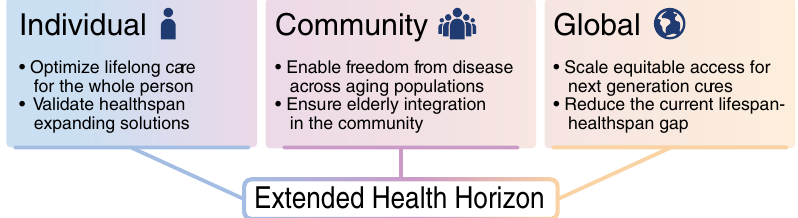
Fig. 4 An equitable healthcare horizon. Healthy longevity mandates synchronized achievements at the individual, community, and global level. For each individual, holistic lifelong care must encompass validated healthspan expanding options. Freedom from disease and integration within the community must be ensured. Globally, in diverse populations, access to next-generation cures must be guaranteed to equitably reduce the healthspan-lifespan